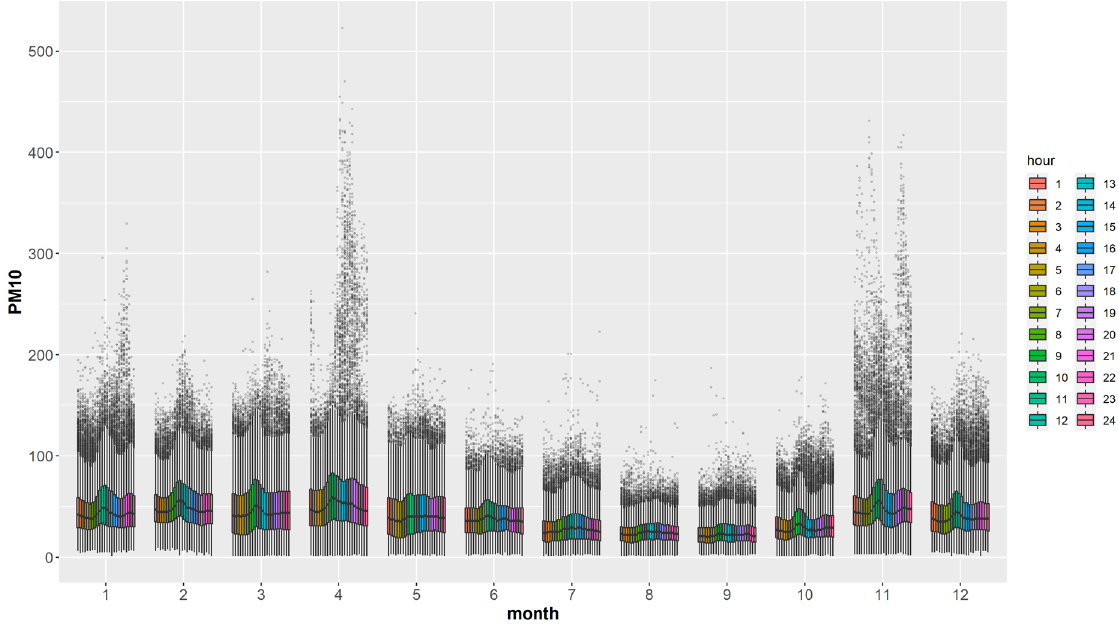
Figure 4. Boxplot of Daily PM10 Concentration in 2018.